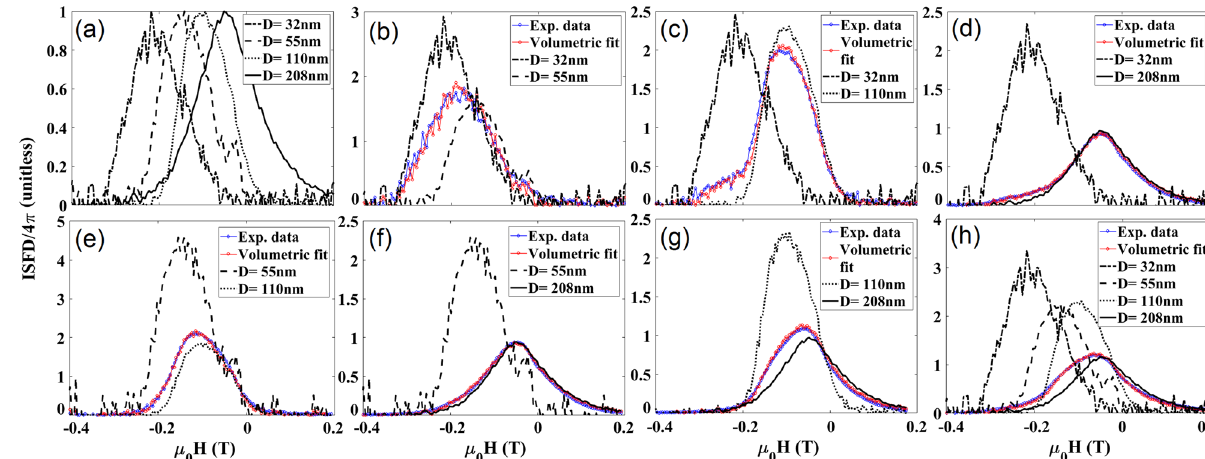
Figure 5. Irreversible switching field distribution (ISFD) results, ( a ) normalized for individual types of MNWs, ( b – g ) different combinations of two types of MNWs, as indicated in the legend and ( h ) one combination of four types. The blue circles show measurements of combinations, and the red circles show the best match for combinations of the individual signatures (from a ) using volume ratio, see Table